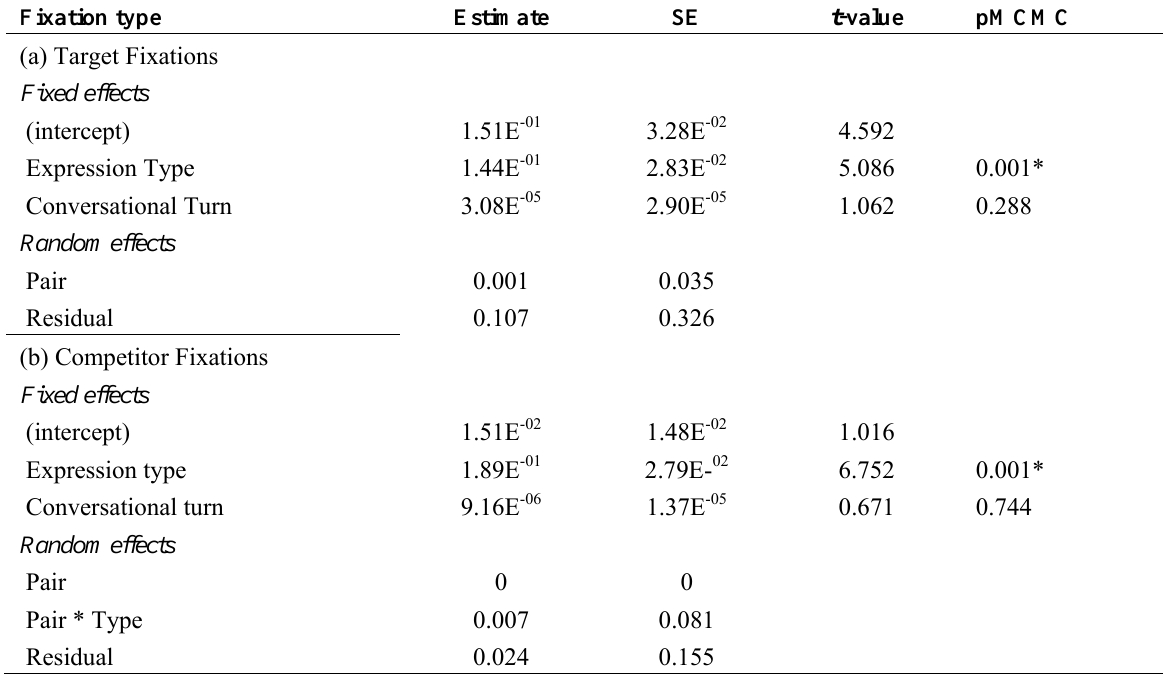
Table 2. Parameter estimates for model of target fixations and competitor fixations, with expression type (ambiguous, disambiguated) and conversational turn as fixed